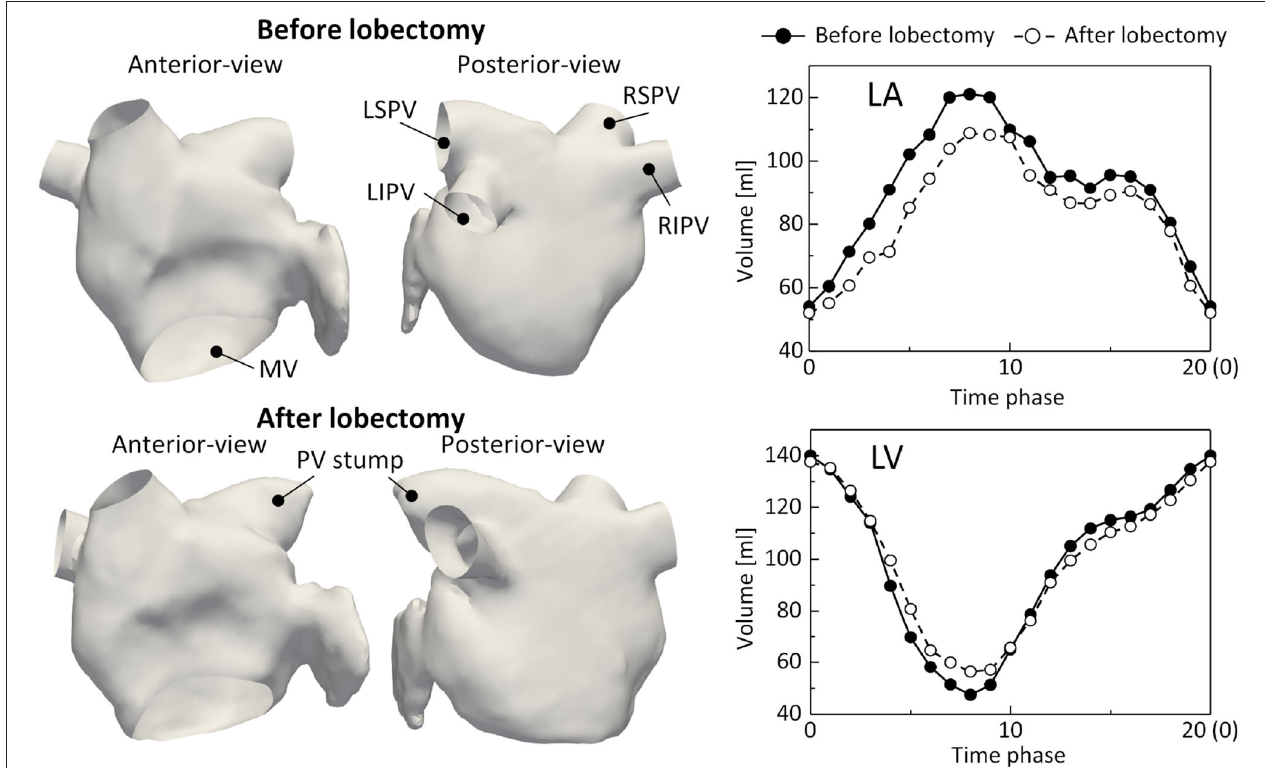
FIGURE 1 | Left atrium (LA) surfaces at phase 0 (left) and time courses of the LA and left ventricle (LV) volumes (right) before and after lobectomy, extracted from 4D-CT images. LSPV, left-superior pulmonary vein; LIPV, left inferior pulmonary vein; RSPV, right superior pulmonary vein; RIPV, right-inferior pulmonary vein, and MV, mitral